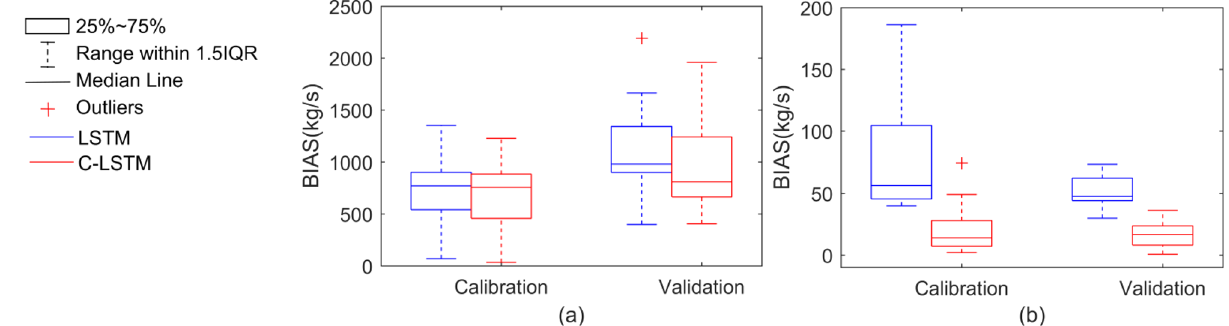
Figure 5. Box plot of BIAS indicator for Patten1 ( a ) and Patten2 ( b ).